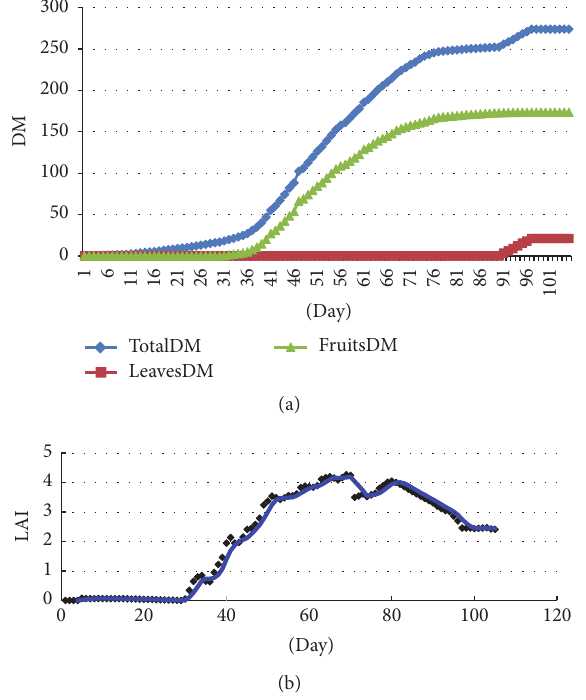
Figure 11: The simulated data of tomato growing. (a) Accumulate dry matter (DM) of the plant (TotalDM), leaves (LeavesDM), and fruit (FruitsDM). (b) Leaf area index (LAI).